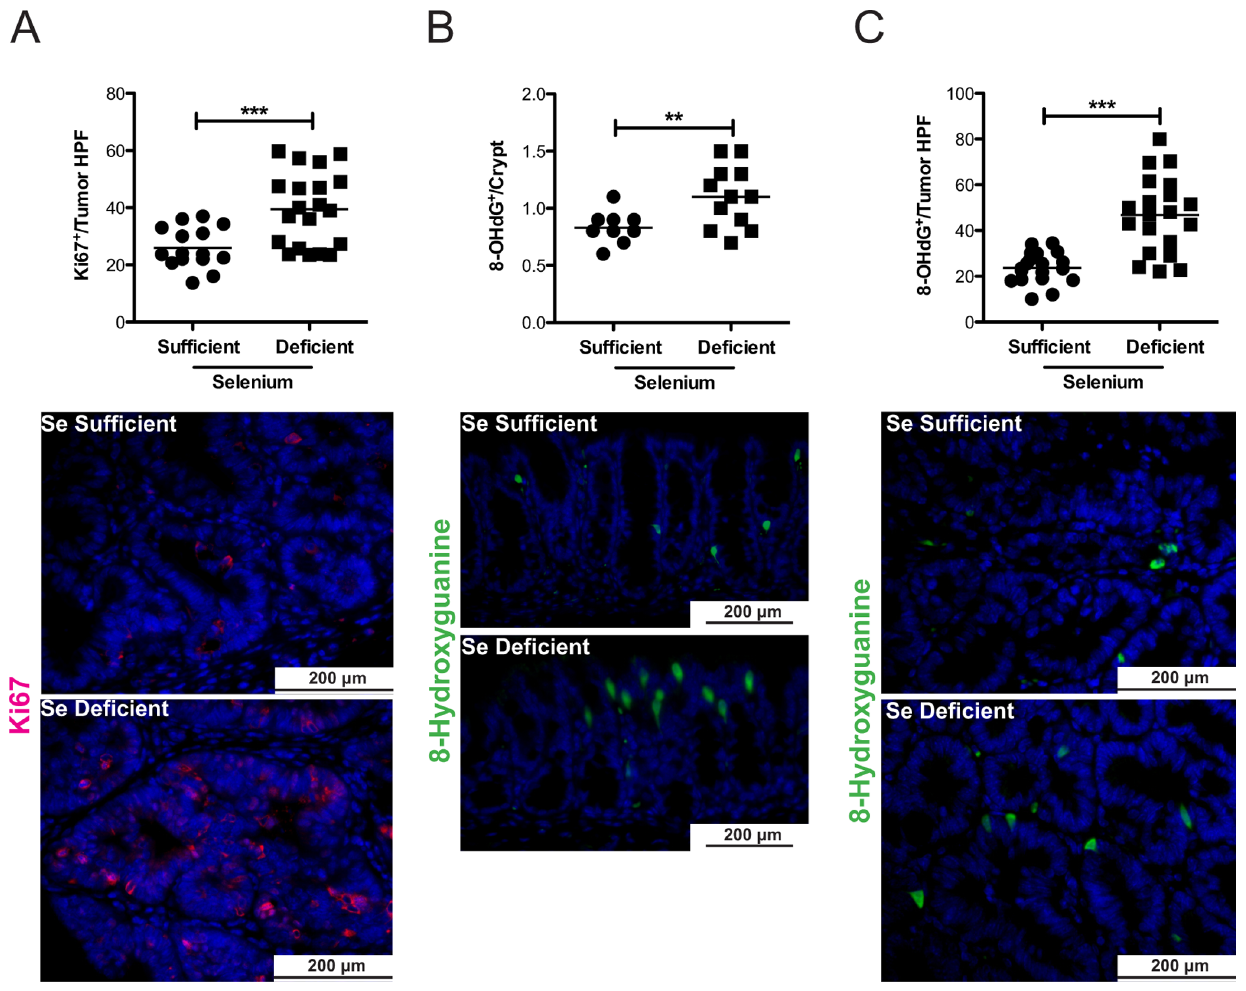
Figure 6. Selenium deficient colons demonstrate increased intratumoral proliferation and DNA damage in response to inflammatory carcinogenesis. Swiss-rolled colons of Se-sufficient and –deficient mice post-AOM/DSS protocol were analyzed for proliferation and DNA damage. A. Ki67 immunohistochemistry was conducted to identify actively proliferating cells. Intratumoral proliferation index calculated from number of Ki67-positive cells per HPF (top, Se-sufficient n=15, Se-deficient n=20, 40 6 ). B. Immunofluorescence for 8-OHdG was conducted according to Materials and Methods. Staining is quantified per longitudinal crypt section in 20 crypts of each mouse (top) and representative images are shown (bottom). C. 8-OHdG staining is quantified per tumor HPF (top, Se-sufficient n=19, Se-deficient n=20, 40 6 ) and representative images are shown (bottom). ** P =0.009, *** P , 0.0001.